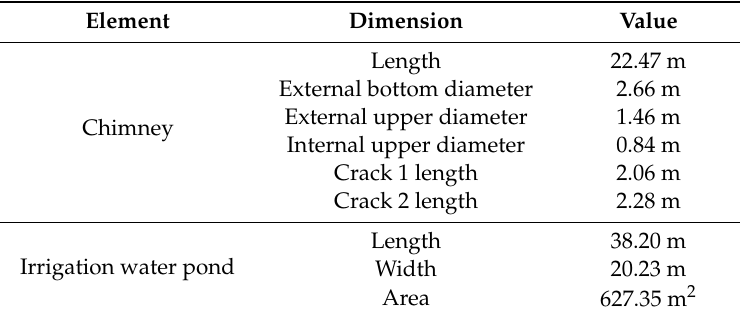
Figure 8. Chimney factory cracks ( a ) crack 1; ( b ) crack 2; ( c ) zenith photograph of the top of the chimney. Table 3. Indirect measurements of chimney and irrigation water